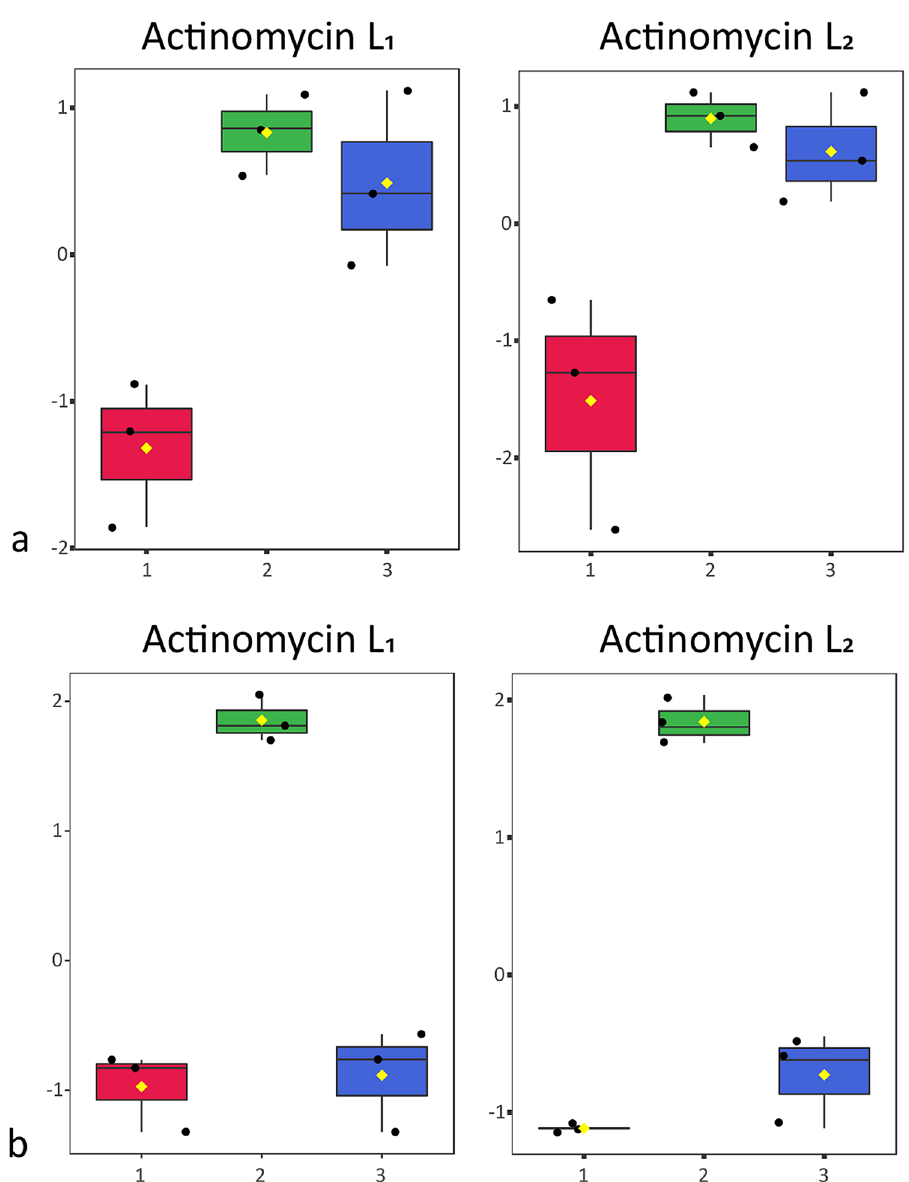
Figure 6. Anthranilamide is required for the biosynthesis of actinomycins L 1 and L 2 . Box plots show the relative intensities of actinomycin L 1 and L 2 after log transformation and pareto scaling in the cultures of Streptomyces sp. MBT27 ( a ) and S. antibioticus ( b ) fermented for 7 days in MM with fructose (1% w/v) (1), fed with 0.7 mM anthranilamide (2) and 0.7 mM anthranilic acid (3). Note that S. antibioticus produces actinomycin L exclusively in the presence of anthranilamide and not with anthranilic acid; conversely, Streptomyces sp. MBT27 is able to convert anthranilic acid into anthranilamide, enabling the production of actinomycin